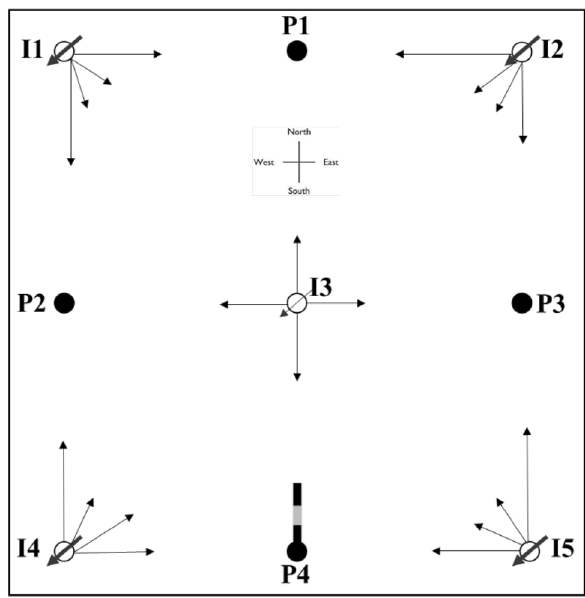
Fig. 23 Distribution of f ij in case V. P 4 is multi-segmented horizontal well, drilled toward the North. Each black arrow and its length repre- sent the connectivity and magnitude,